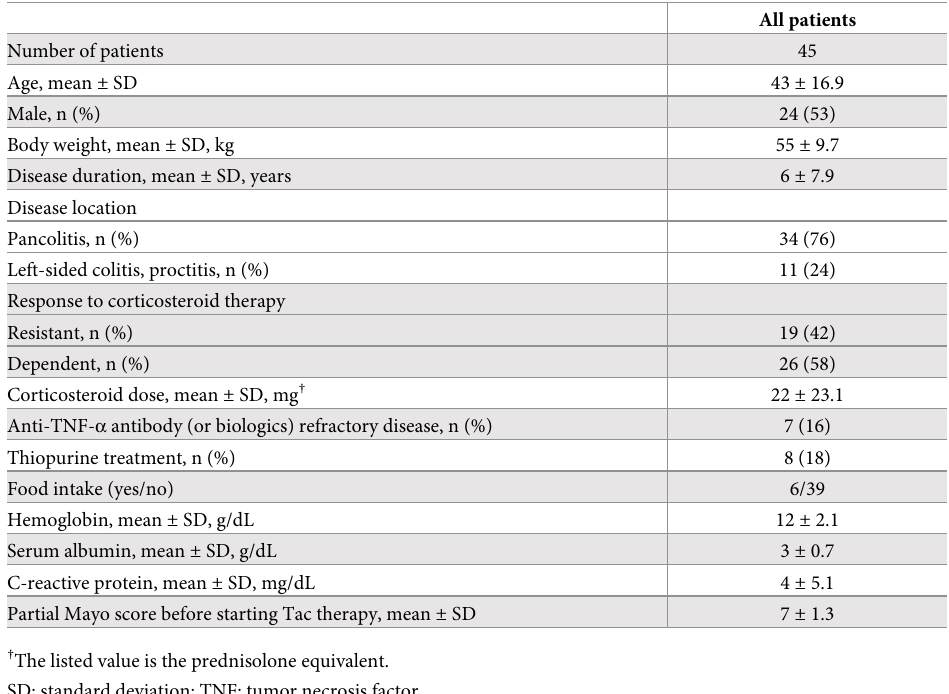
Table 1. Baseline characteristics of